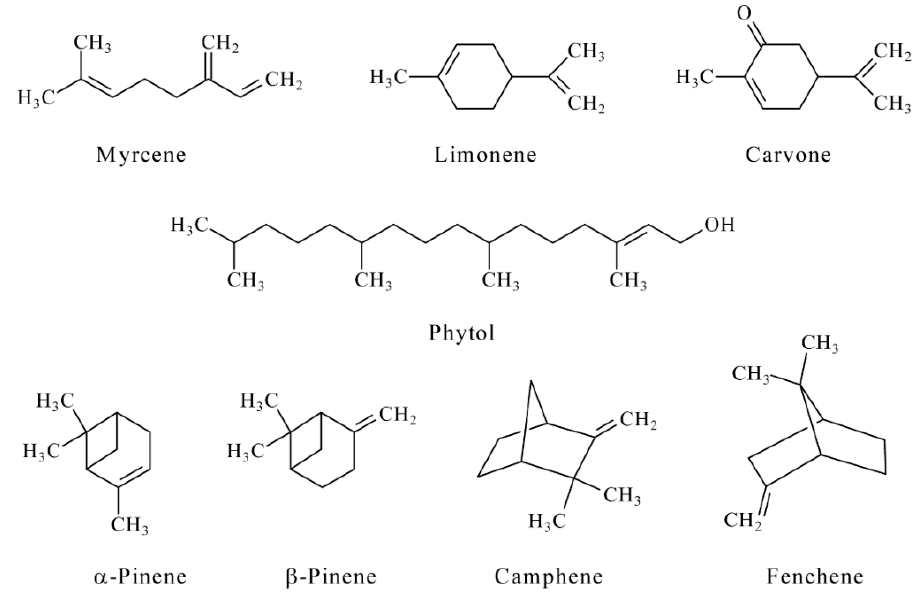
Figure 3. The structure of the terpenes under consideration.